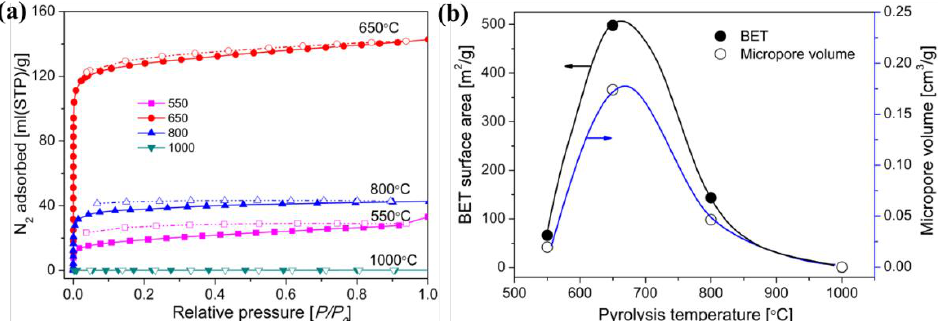
Figure 14. ( a ) N 2 adsorption–desorption isotherms at 77 K, ( b ) BET surface area and micropore volume (at a relative pressure of P/P 0 = 0.01, pore size ≤ 1 nm) of pyrolyzed precursor (TiPCS) powders. Adapted from [55] with permission from